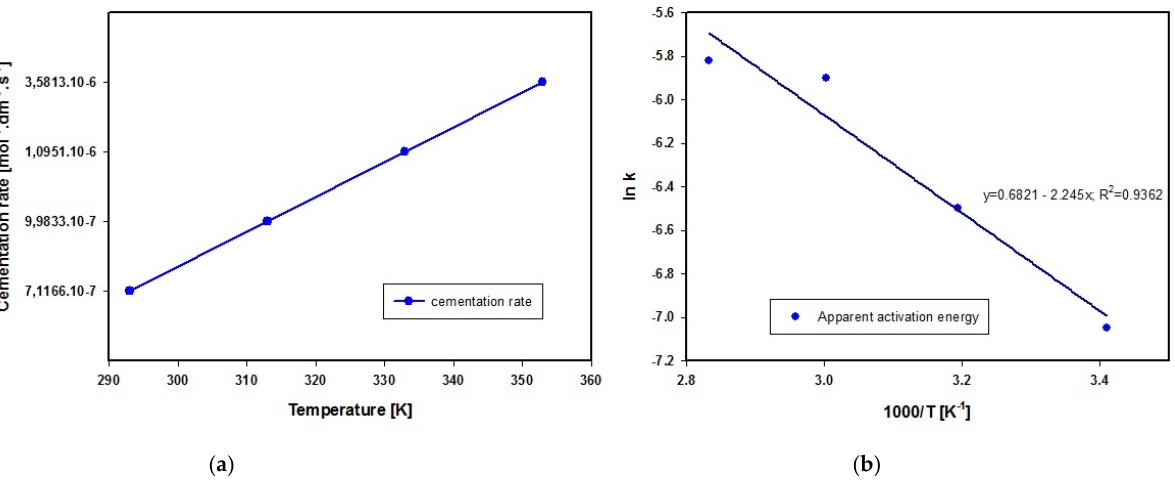
Figure 8. ( a ) Lead c ementation r ate at different temperatures of solution. ( b ) The Arrhenius equation expresses the interdependence of temperature and rate constant in chemical reactions.